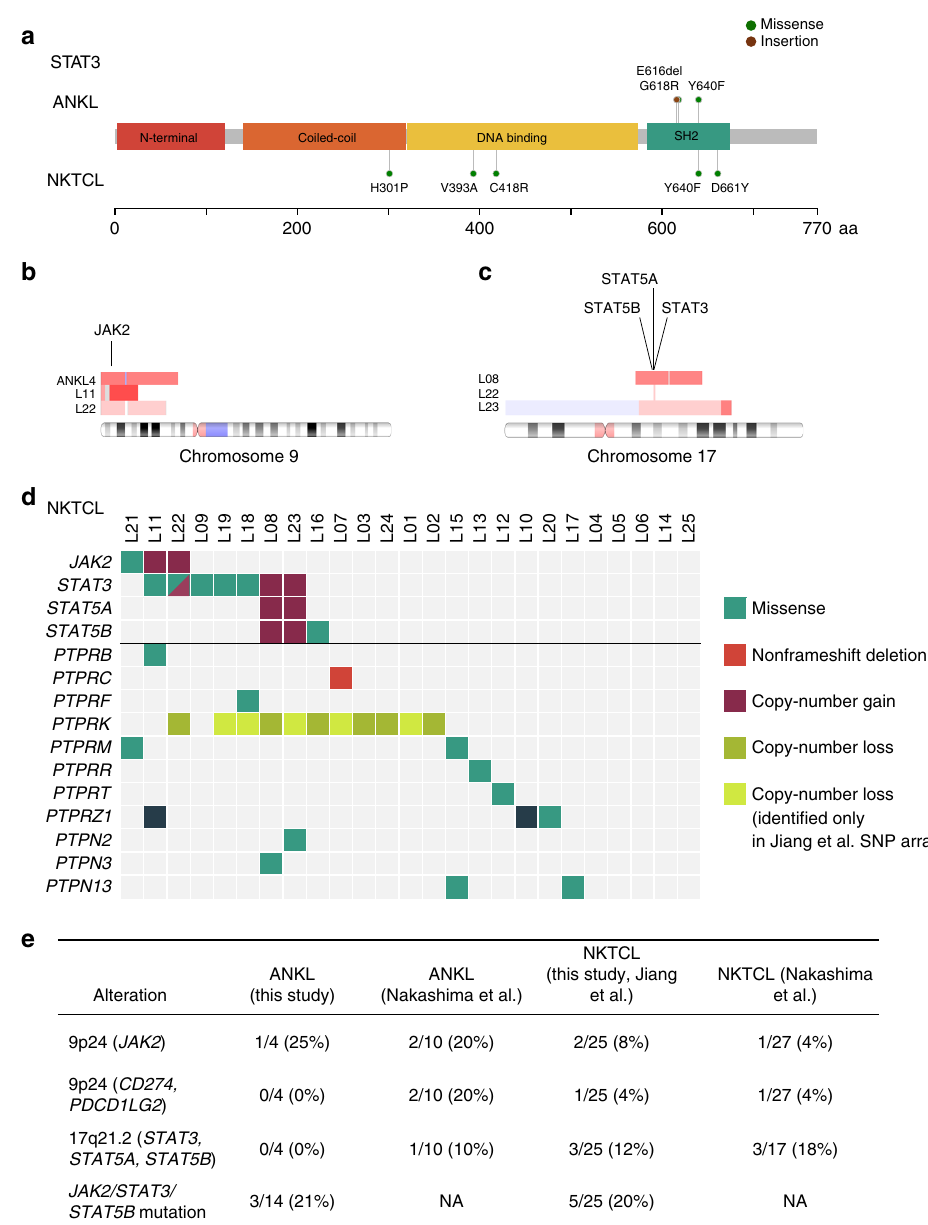
Fig. 2 JAK-STAT pathway component alterations are common characteristics in both ANKL and NKTCL. a Somatic mutations identi fi ed in STAT3 in ANKL ( n = 14) and NKTCL ( n = 25) patients. b – c Ideograms of chromosome 9 ( b ) and 17 ( c ) showing the areas of copy number alterations identi fi ed in ANKL and NKTCL. Red bars indicate gains and blue bars indicate losses. Patient IDs are indicated on the left and the locations of JAK-STAT genes are displayed. Only patients with gains are shown. d JAK-STAT and PTP alterations in NKTCL. Both alterations detected in this study using reanalyzed WES data and alterations detected by Jiang et al.[11] using SNP arrays are shown. Diagonally split dual-colored rectangle indicates the presence of two alterations of different type in the same sample. e Summary of JAK-STAT alterations identi fi ed in this study and in Nakashima et al.